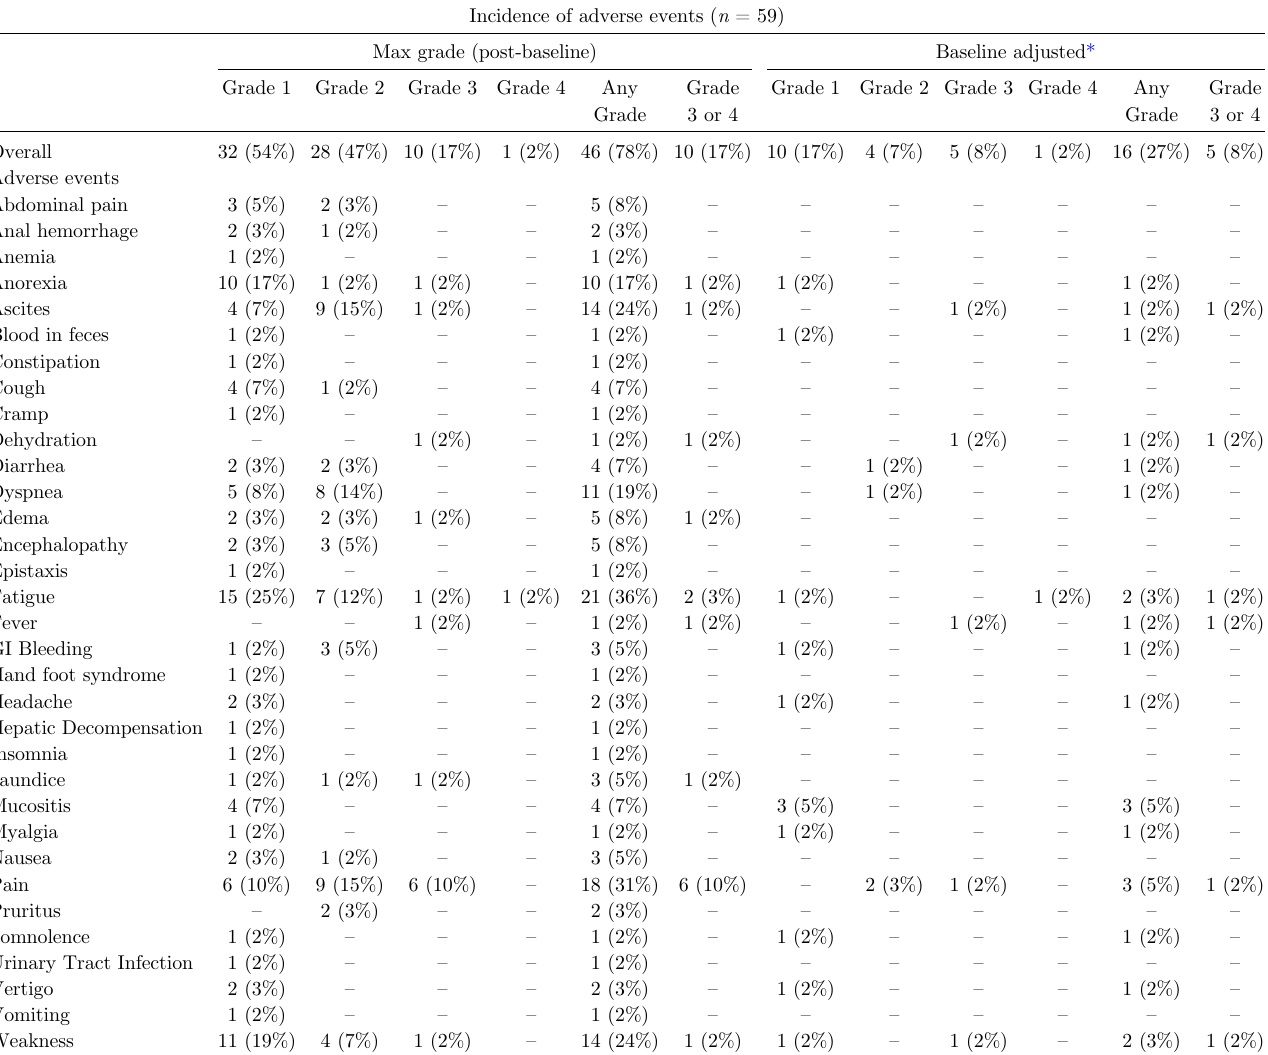
Table 3. Adverse Events Summary – Current Study + Phase I/II ( n = 59). Adverse events reported by NCI CTCAE grade in all patients receiving treatment with the TheraBionic